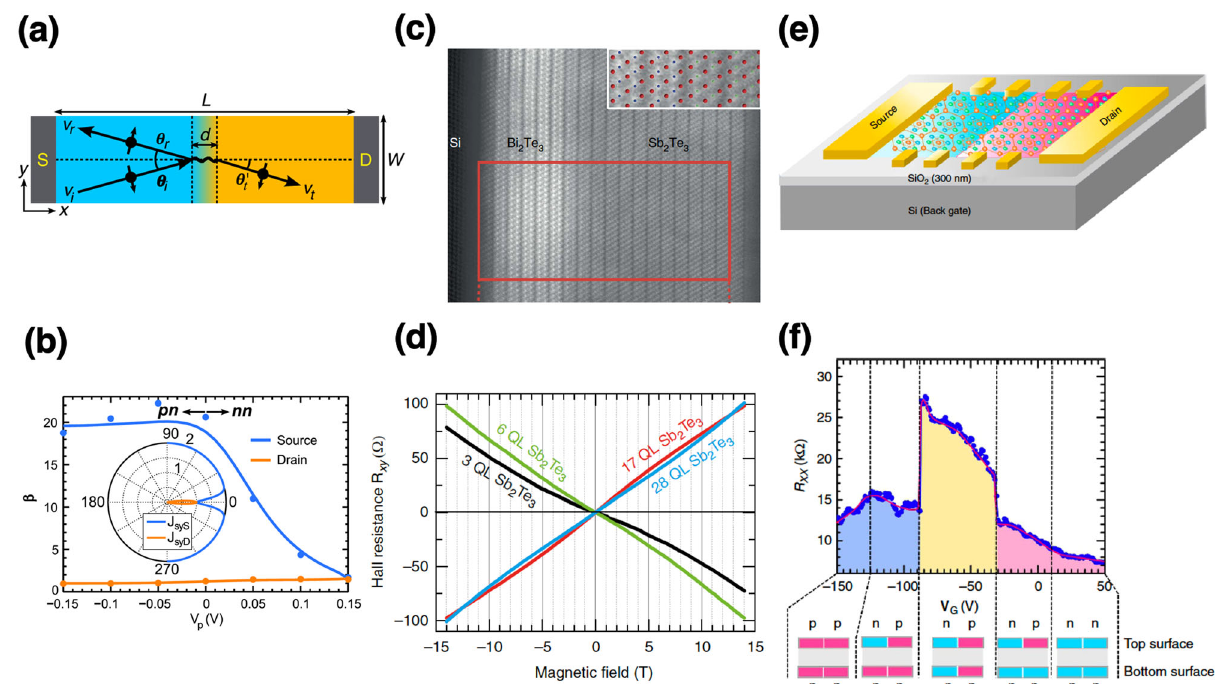
Fig. 3 Topological p – n junctions. a Theoretical schematic illustrating the surface of a 3D TI p – n junction with incident, re fl ected, and transmitted electrons shown with their corresponding spin polarizations. Image taken from ref. 47 . b Calculated quantum transport results showing the spin-to-charge ratio, β , at the source and drain contacts as a function of the gate voltage V p applied to the p-type part of the junction at a fi xed gate voltage on the n-type part of the junction. We observe a large enhancement in β at the source contact in a topological p – n junction due to the spin-momentum locking of the surface states of a 3D TI. Image taken from ref. 47 . The inset shows that the transmitted current is only non-zero when the incident electrons are normal to the surface of the junction. c A high-angular annular dark fi eld image of two MBE-grown binary 3D TIs, 15 QL of Sb 2 Te 3 , and 6 QL of Bi 2 Te 3 in direct contact with one another. Image taken from ref. 49 . d Experimentally measured Hall resistance of various heterostructures comprised of 6 QL of Bi 2 Te 3 with differing Sb 2 Te 3 thicknesses. Image taken from ref. 49 . e Schematic of a horizontal p – n junction with a Si back gate to tune the location of the chemical potential. On one half of the surface, an electronegative molecule is deposited on the surface to draw out the unintentional bulk carriers allowing greater manipulation of the chemical potential with electrostatic gating 48 . f Quantum transport measurements of the longitudinal resistance of topological p – n junction as a function of back-gate voltage V G showing a large jump in resistance when there are p – n junctions formed on both the top and bottom surfaces. The jump in resistance is attributed to the spin-momentum locking of the surface states in a 3D TI 48